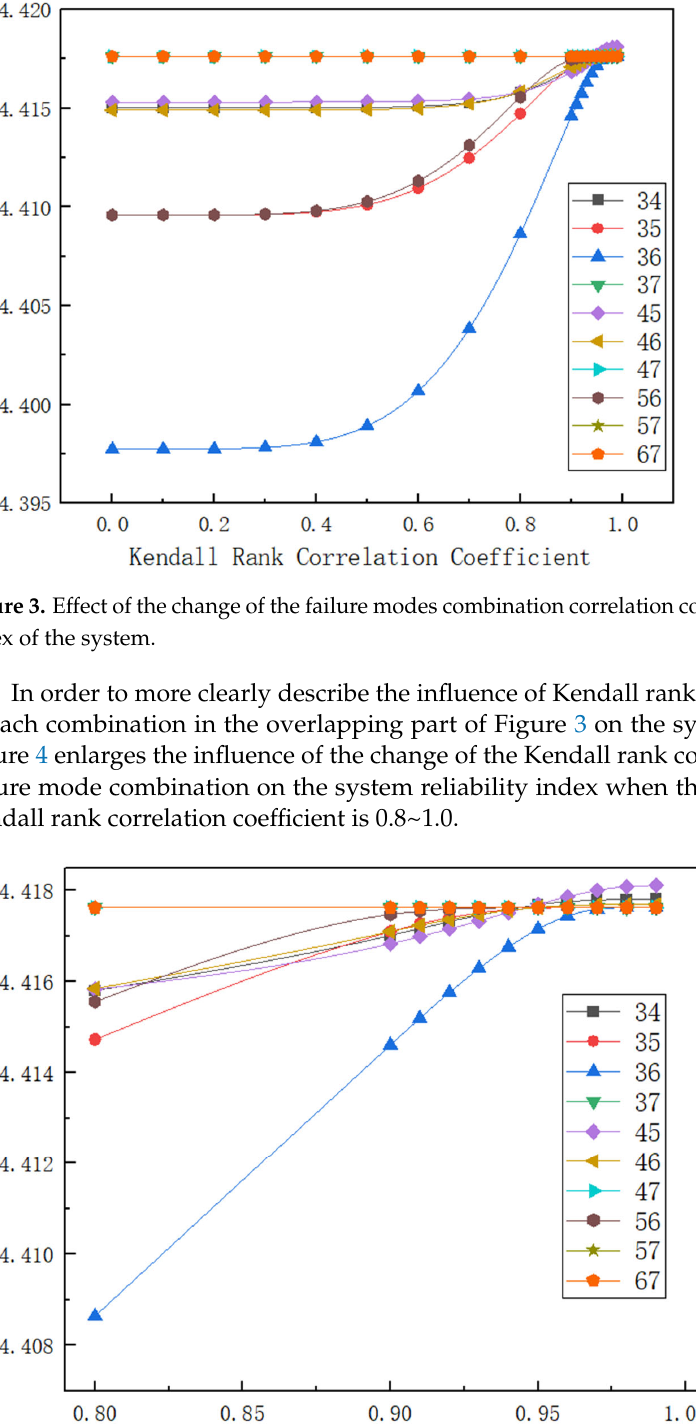
Figure 4. The influence of the change of the Kendall rank correlation coefficient on the reliability index of the system when the change range of the Kendall rank correlation coefficient is 0.8~1.0.